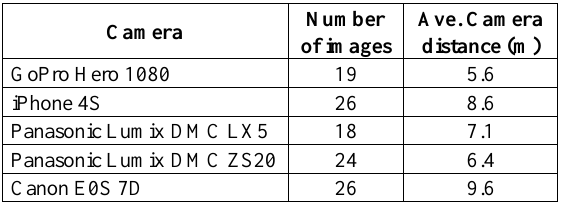
Table 2. Number of images used in the reconstruction process and average camera distance to the wall for each